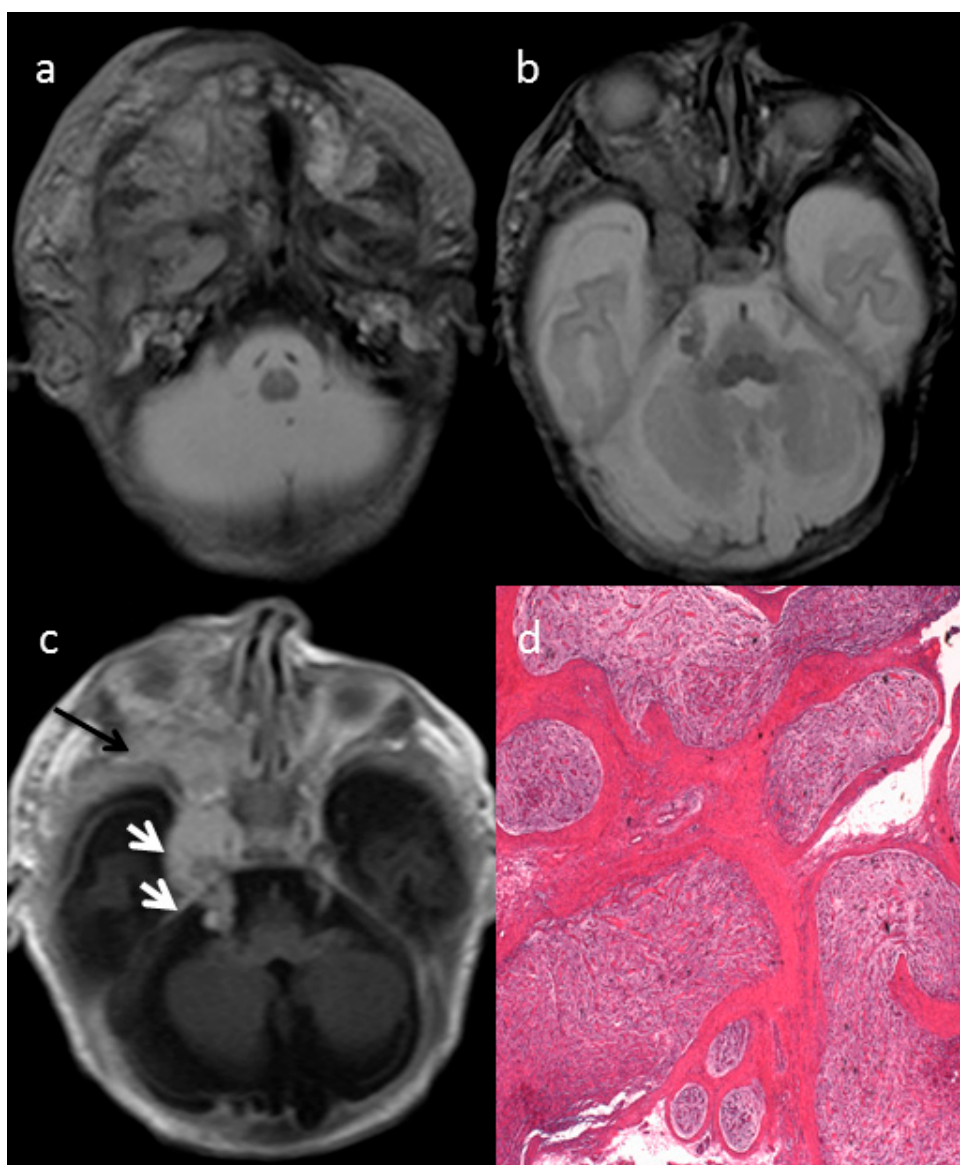
Figure 1. The axial T2-w ( a , b ) and T1-w ( c ) of the MRI showed an ill-defined giant cervical and facial mass of the right side on the neck deep spaces with infra-temporal fossa and intra-orbital extension and parotid gland infiltration. The intracranial extension followed the course of the right trigeminal nerve (( c ) white arrows). The mass involved the deep regional soft tissues causing a proptosis of the right eye (( c ) black arrow). The optic nerve and extra-ocular muscles were involved by the mass ( b , c ). The histologic examination after mass biopsy revealed diffuse nerve fascicles distension caused by a proliferation of spindle-shaped cells embedded in myxoid matrix (hematoxylin-eosin (EE), 2.5 ×) consistent with plexiform neurofibroma (PN) ( d ).